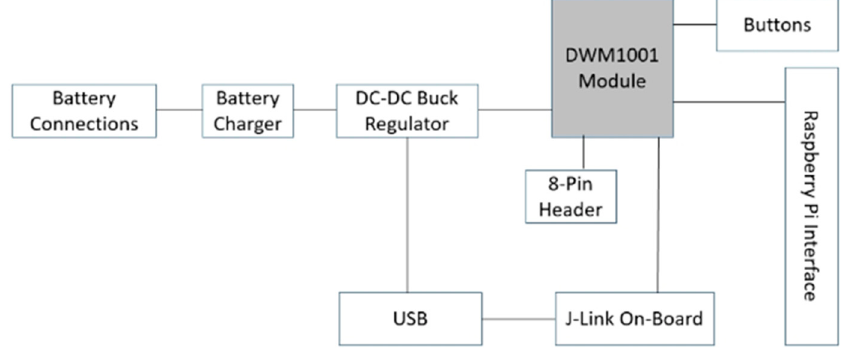
Figure 1. Block diagram of DWM1001 module [35].